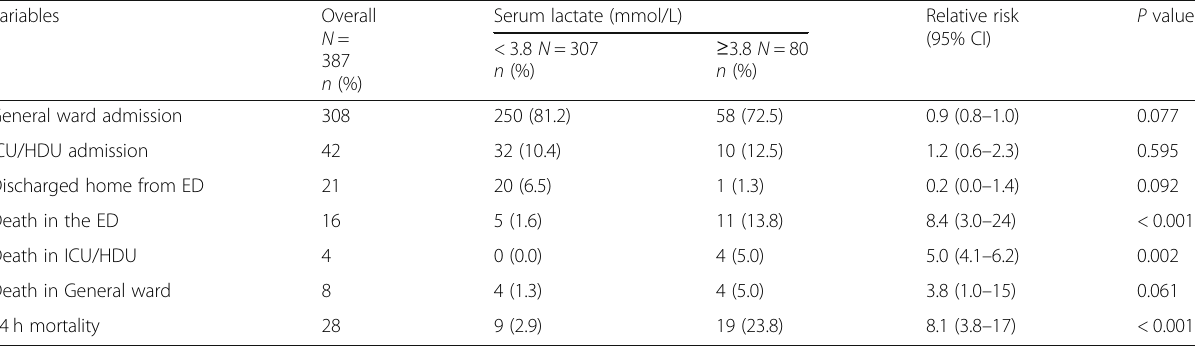
Table 5 Patients disposition and hospital outcomes Variables